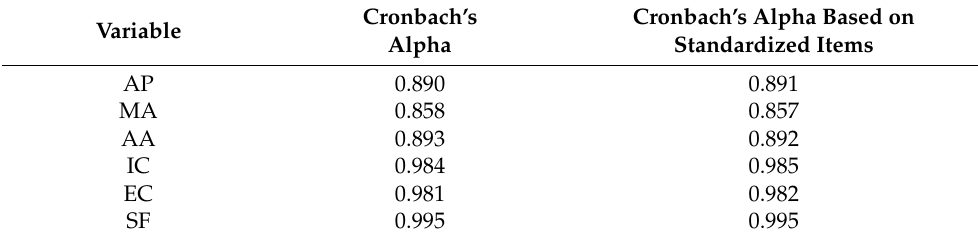
Table 3. Summary of processed cases of variables. Reliability